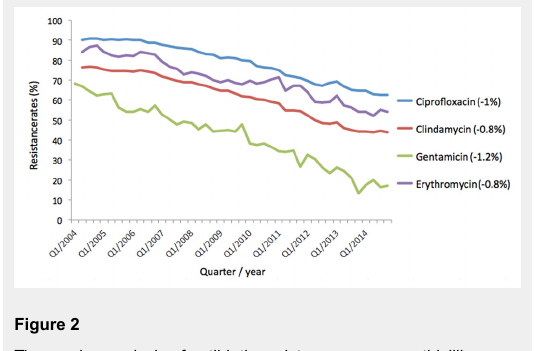
Time series analysis of antibiotic resistance among methicillin- resistant S. aureus (MRSA) isolates. Trends per quarter are given in parentheses.